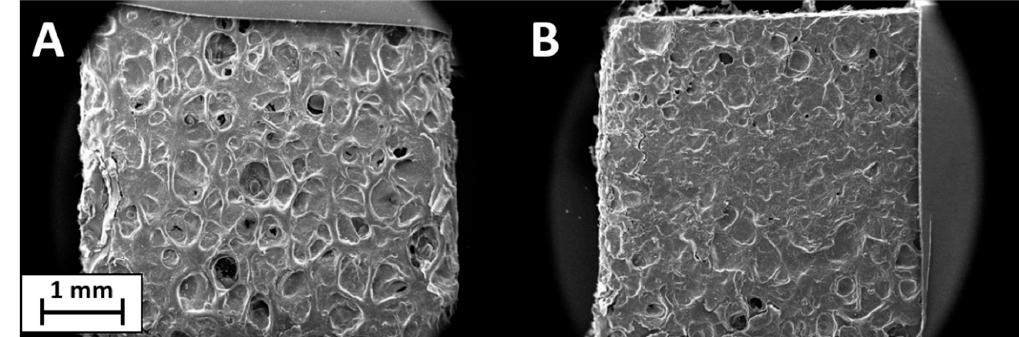
Figure 8. SEM images of PSS/GNPs coating after ageing treatment for 48 h ( A ) and 115 h ( B ). During flame penetration tests on both heat-treated samples, the flame was not able to penetrate the specimens even after 400 s of flame application. Furthermore, tempera- tures of the exposed face remained constant below 300 °C, while the back face was quite stable between 25 and 35 °C.